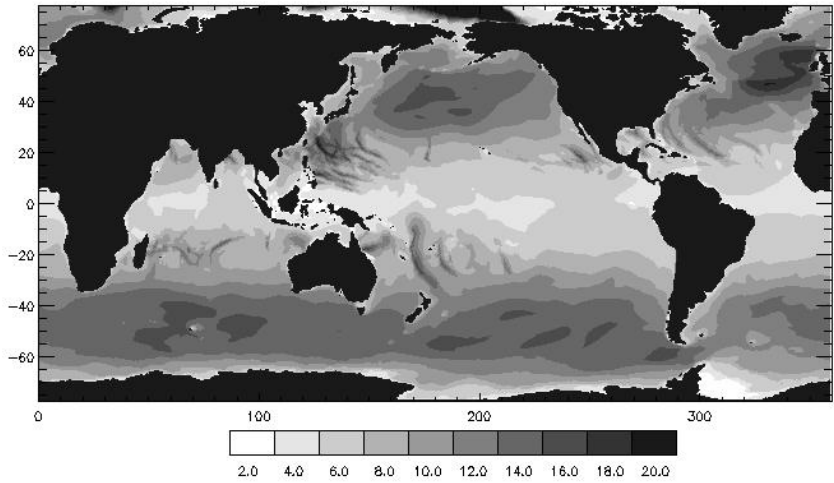
Figure 1. Wave heights (m) above mean level with a cumulative probability of 10 − 7 , annual